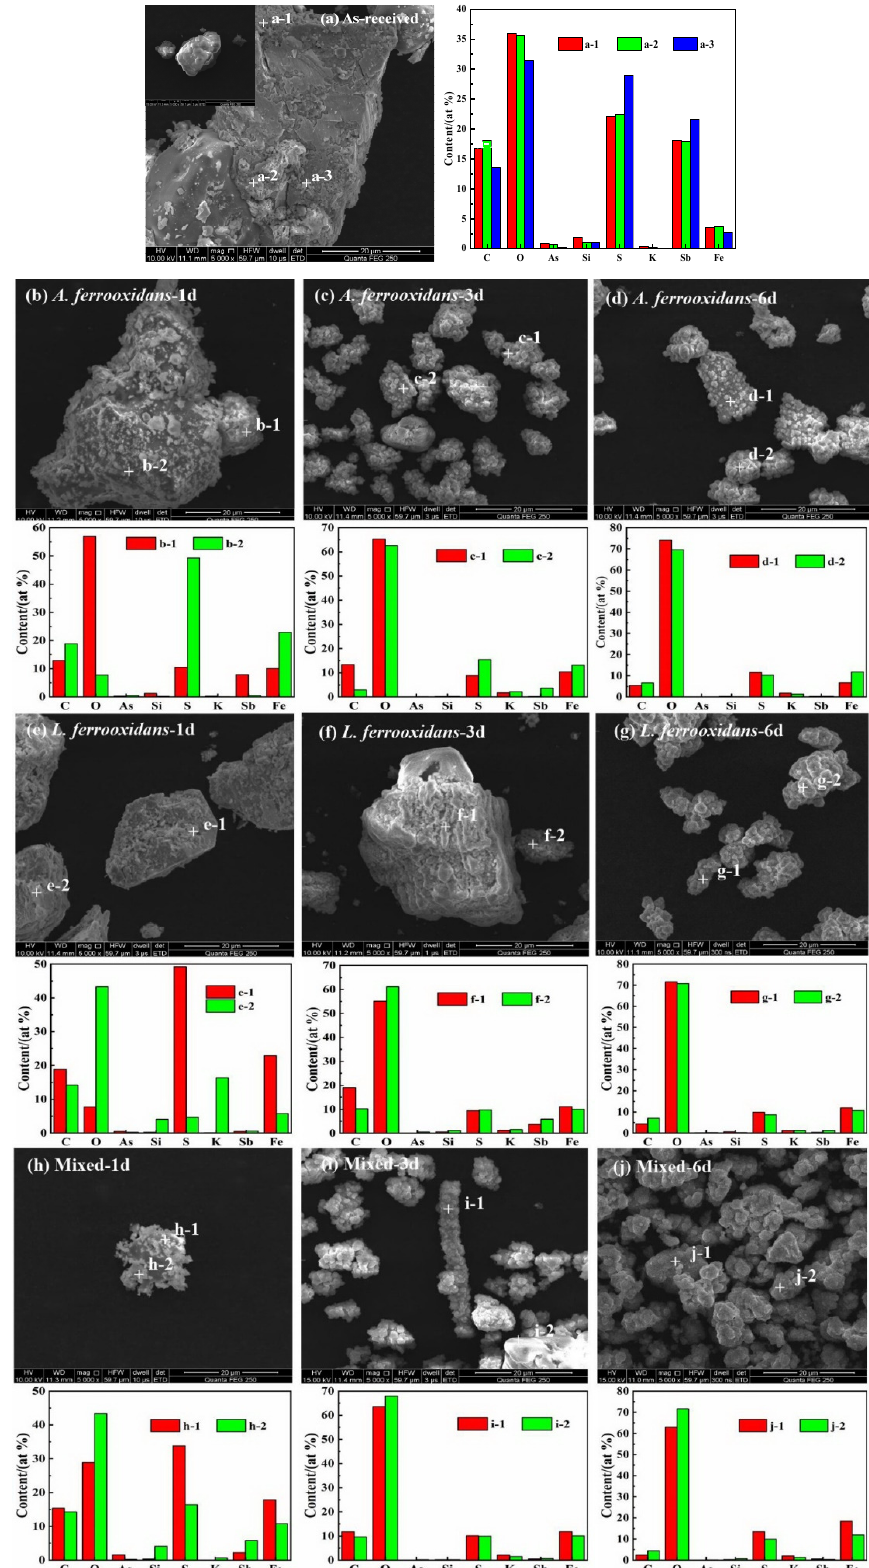
Figure 3. SEM images with EDS data (at.%) for the as-received sample (DRGO) and the DRGO after oxidizing 1 d, 3 d and 6 d in 9 K culture medium. ( a ) As-received; ( b – d ) A. ferrooxidans ; ( e – g ) L. ferrooxidans ; ( h – j ) Mixed culture.